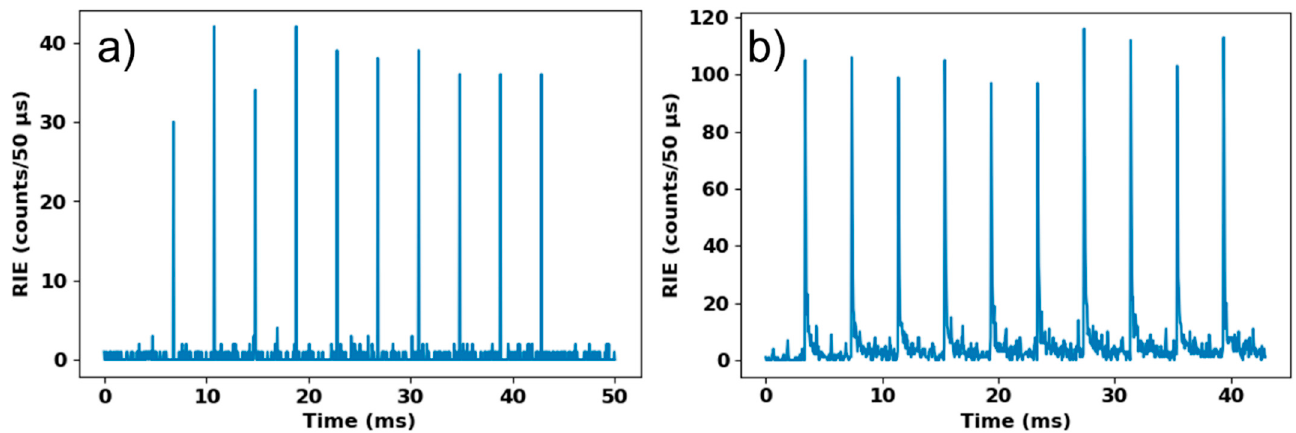
Figure 11. RIE measurement associated with a train of 10 X ‐ ray pulses cadenced at 250 Hz ( a ) as measured by the RHF fiber only. ( b ) As measured by the RHF ‐ Ce ‐ doped samples.